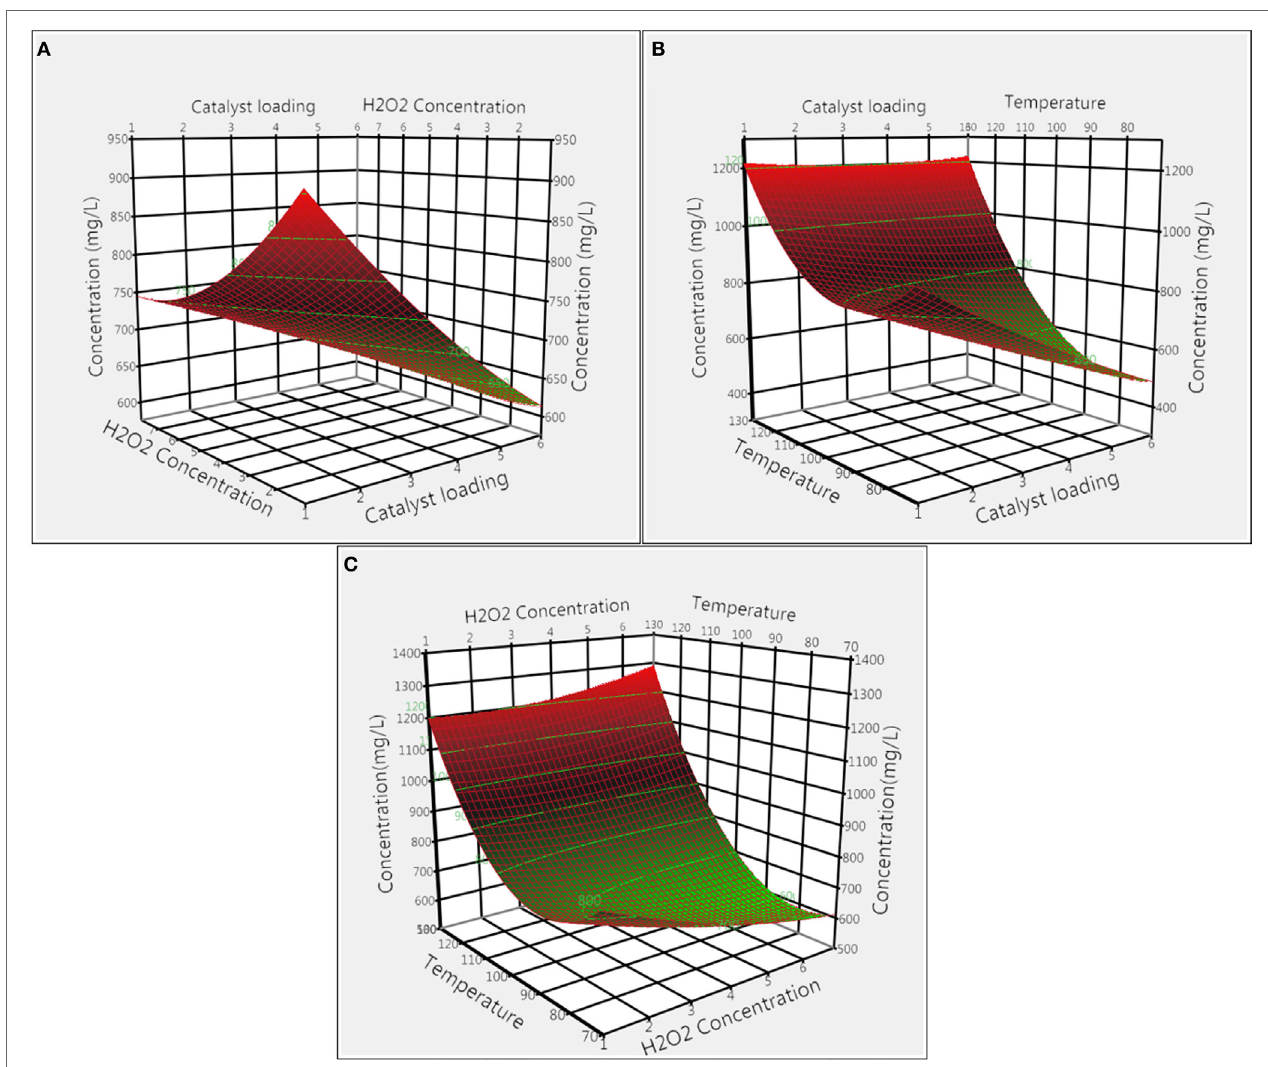
FigUre 3 | Surface response plots showing the effect of CoCl 2 catalyst on product concentration: (a) catalyst loading and H 2 O 2 concentration, (b) catalyst loading and temperature, and (c) temperature and H 2 O 2